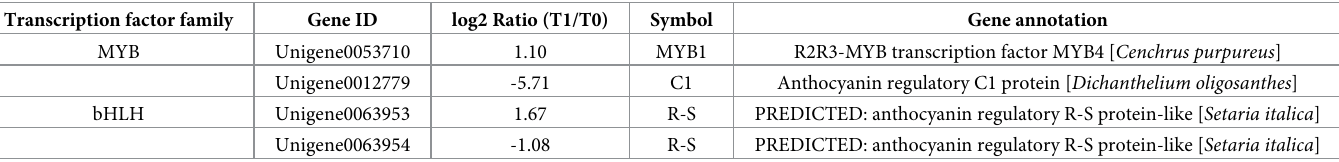
Table 5. Differentially expressed transcription factors associated with anthocyanin biosynthesis in Pennisetum setaceum ‘Rubrum’. Transcription factor